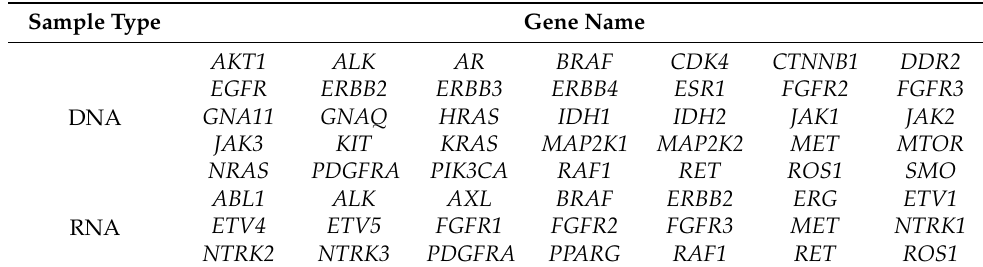
Table 1. Cancer-related genes that can be analyzed with next-generation sequencing using the Oncomine TM Dx Target